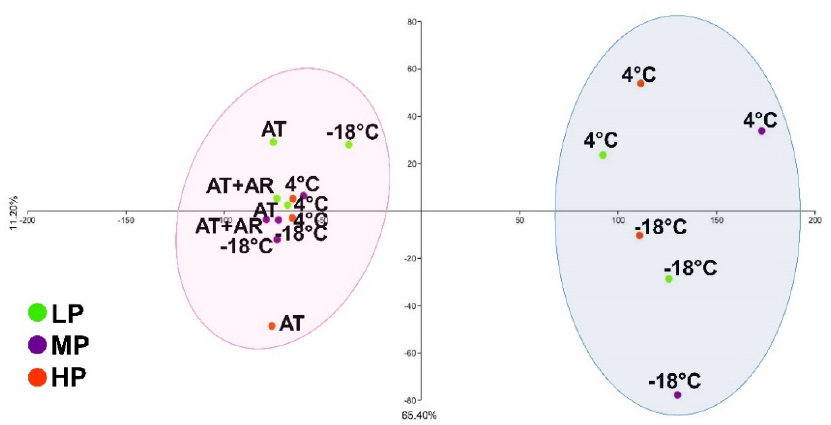
Figure 4. The scatter plot of the principal component analysis (PCA) using the percentage of reduction in content of twenty-two chemical parameters from T18 to T18-8 m (pink area) and between T18 and T36 (blue area) conditions. Colored circles indicate the type of oil, green: LP oil; purple: MP oil; orange: HP oil.